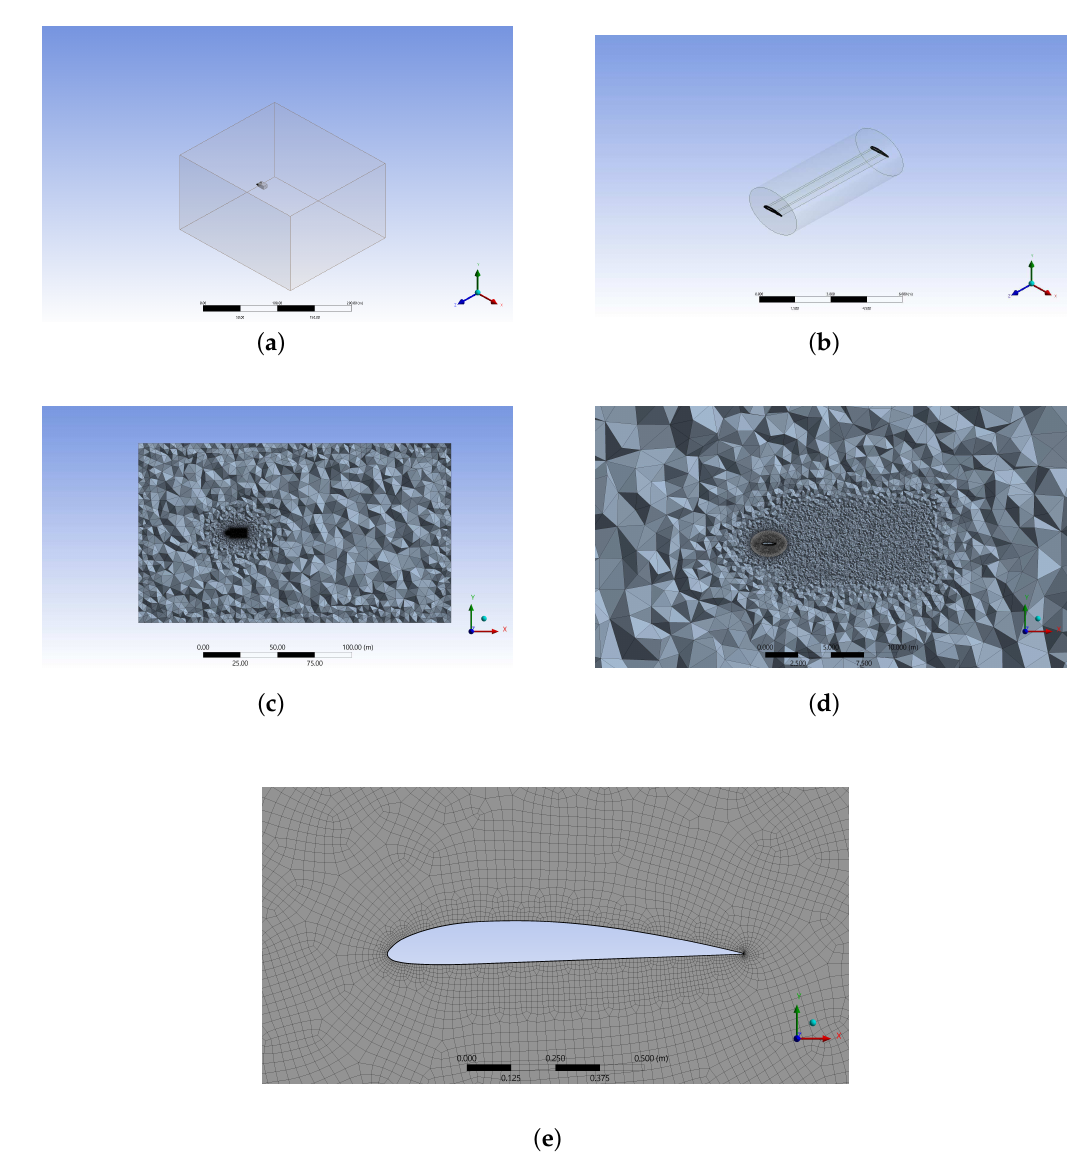
Figure A4. 3-D wing CFD simulation setup: ( a ) the solution domain that is 210 × 180 × 120 m ( L × W × H ); boundary conditions are: velocity inlet over the upstream, top, bottom and sides of the domain, pressure outlet over the downstream boundary and no-slip wall over the faces of the wing, ( b ) refinement zone in which hexahedral elements are swept over the wing (260 elements were made over the edge of the airfoil), ( c ) the side-view of the solution domain (5.1 M elements), ( d ) a close-up view showing the wake region and refinement zone (the wake region was considered up to 25 m downstream of the wing), ( e ) mesh around the wing airfoil section (Clark-Y airfoil, chord: 1 m, Max. thickness: 0.117 m, No. of hexahedral elements around the airfoil: 2.9 M, No. of inflation layers around the airfoil: 22, growth ratio: